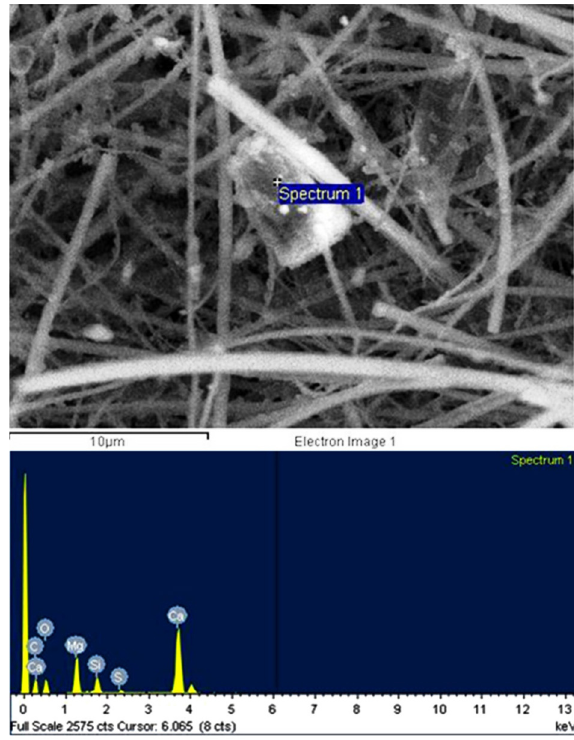
Figure 4. SEM micrograph and EDS spectrum of the mineral phase, corresponding to Dolomite (CaMg(CO